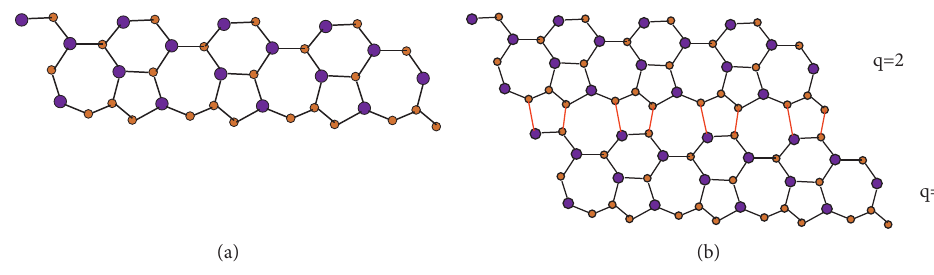
− I [ 4 , 1 ] , one row with m � 4 and n � 1; (b) Si C 2 3 Table 1: Vertex partition of Si